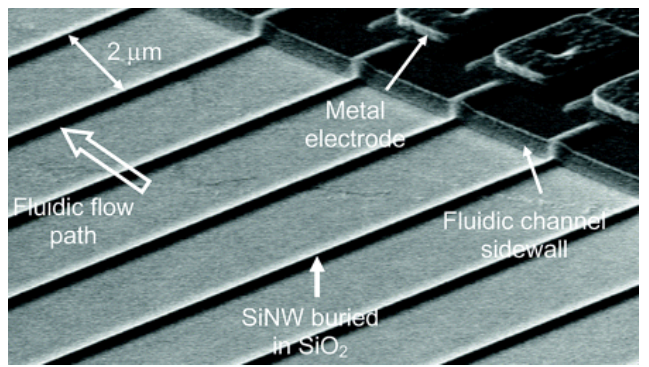
Figure 8. Scanning electron microscope photograph of a silicon nanowire array fabricated by CMOS compatible technology. From Gao et al ., Anal. Chem . 2007 , 79 , 3291-3297. Reprinted with permission from